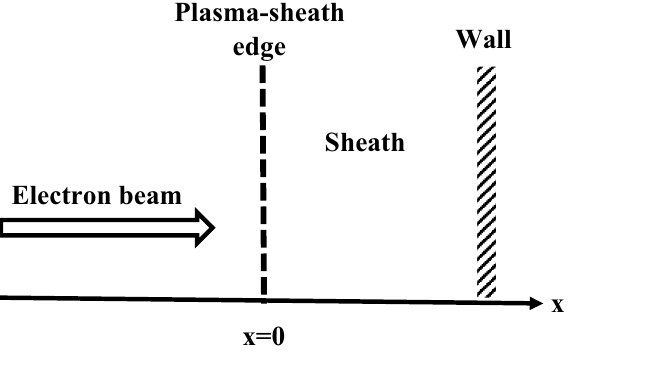
Figure 1. Schematic geometry of the sheath